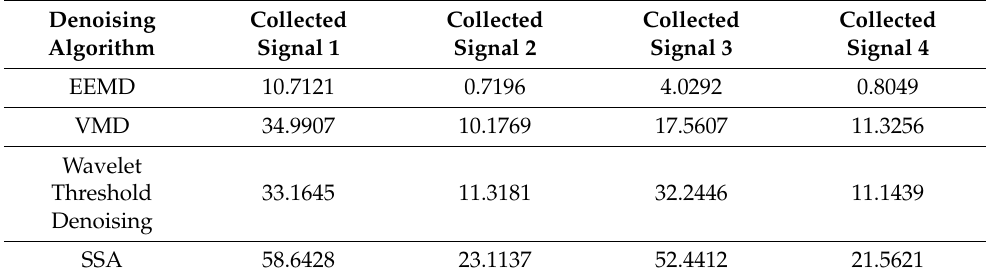
Table 2. Table of signals SNR comparison after EEMD, VMD, wavelet threshold denoising, and SSA processing.